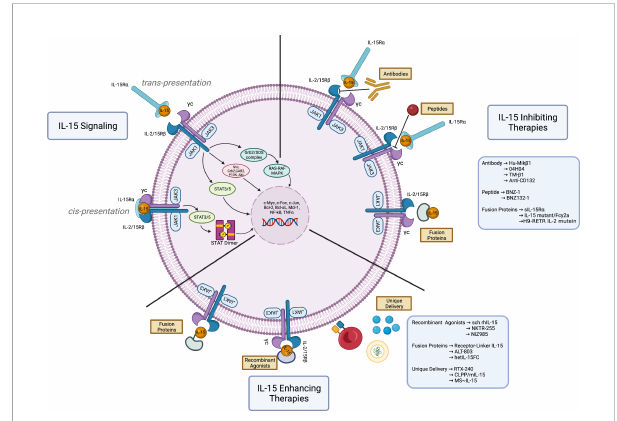
FIGURE 1 Therapeutic approaches on Interleukin-15 signaling. IL-15 signaling. Interleukin-15 (IL-15) plays a major role in the immune responses by serving as a growth factor for T- and NK-cells. Normal IL-15 signaling begins following the binding of IL-15, produced by dendritic cells, with its high af fi nity receptor IL-15R a on the same cells (cis presentation). Upon binding, it is trans- presented to the IL-2R/15R b - g c receptor complex expressed by T- and NK-cells, which consequently activates JAK1/JAK3 along with STAT3/5, PI3K/Akt and Ras/Raf/MAPK. These signaling cascades trigger a transcriptional program aimed at boosting the anti-pathogens in fl ammatory response and enhancing the anti- tumoral immune response. Paradoxically, the overexpression of IL-15 can result in the development of hematological malignancies. IL-15 inhibiting therapies. Numerous interventions have been developed to block IL-15 signaling and the T- and NK- cells tumoral proliferation. Some examples are anti-IL-15 antibody (Hu-Mik b 1, 04H04, TM- b 1, anti-CD-132), peptide antagonists (BNZ-1, BNZ132-1), and fusion proteins (soluble IL- 15R a -sIL15R a , IL-15 mutant/Fc g 2a, H9-RETR IL-2 mutein). IL-15 enhancing therapies. Highly ef fi cient immune response enhancing agents have been developed to leverage the ability of IL-15 to boost the anti-tumoral effector cells. The fi gure depicts recombinant agonists (sch rhIL-15, NKTR-255, NIZ985), fusion proteins (receptor linker IL-15 or RLI, ALT-803, hetIL-15FC), and unique delivery systems (RTX-240, CLPP/mIL-15, MS~IL-15). These compounds boost the immune response against tumoral cells and can potentiate the effect of immunotherapy and adoptive cell therapy. Figure made with